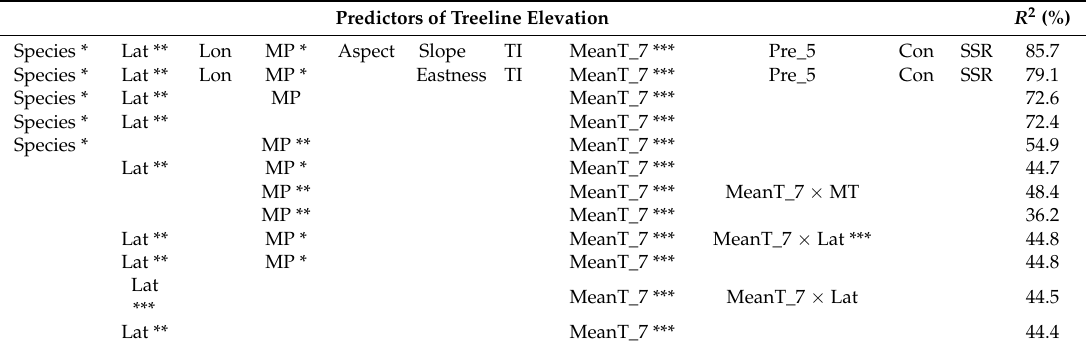
Table 3. Relative importance of predictors of treeline elevation across the Tibetan Plateau and variance explained ( R 2 ) by generalized linear models.